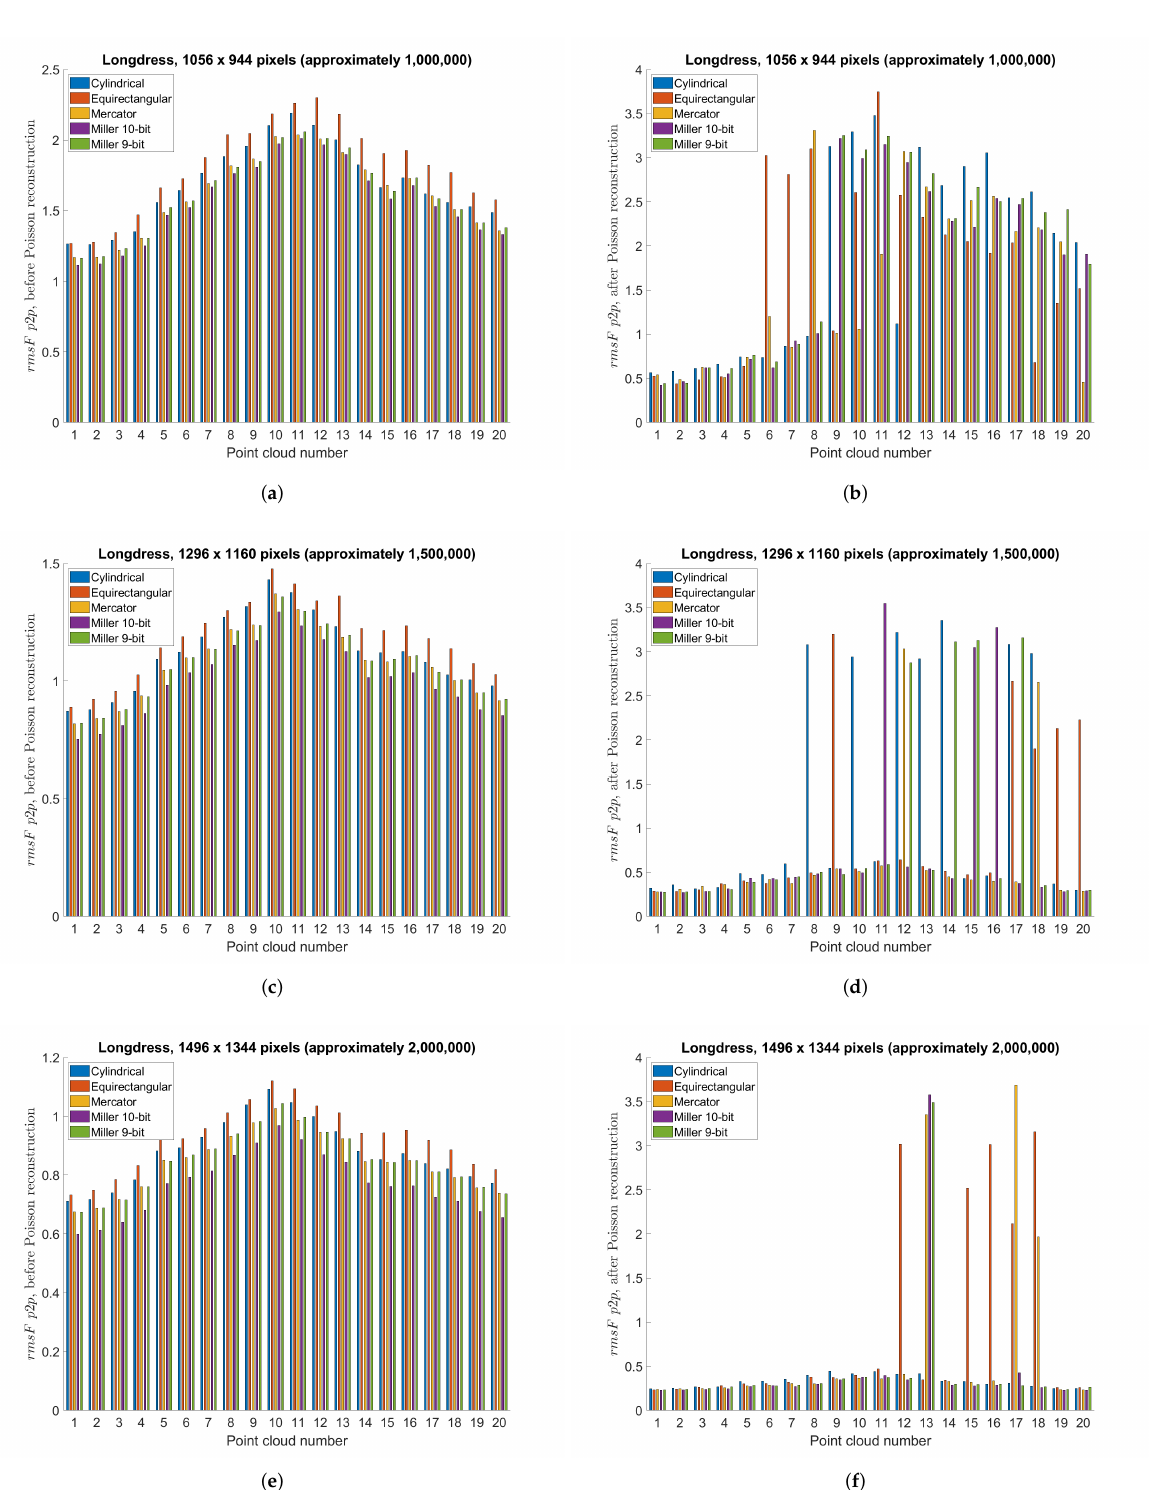
Figure 14. Point-to-point objective measure per point cloud, using cylindrical, equirectangu- lar, Mercator, Miller 10-bit and Miller 9-bit projections: ( a ) before Poisson reconstruction, pro- jection area 1056 × 944 pixels (approximately 1,000,000); ( b ) after Poisson reconstruction, projec- tion area 1056 × 944 pixels (approximately 1,000,000); ( c ) before Poisson reconstruction, projec- tion area 1296 × 1160 pixels (approximately 1,500,000); ( d ) after Poisson reconstruction, projection area 1296 × 1160 pixels (approximately 1,500,000); ( e ) before Poisson reconstruction, projection area 1496 × 1344 pixels (approximately 2,000,000); ( f ) after Poisson reconstruction, projection area 1496 × 1344 pixels (approximately